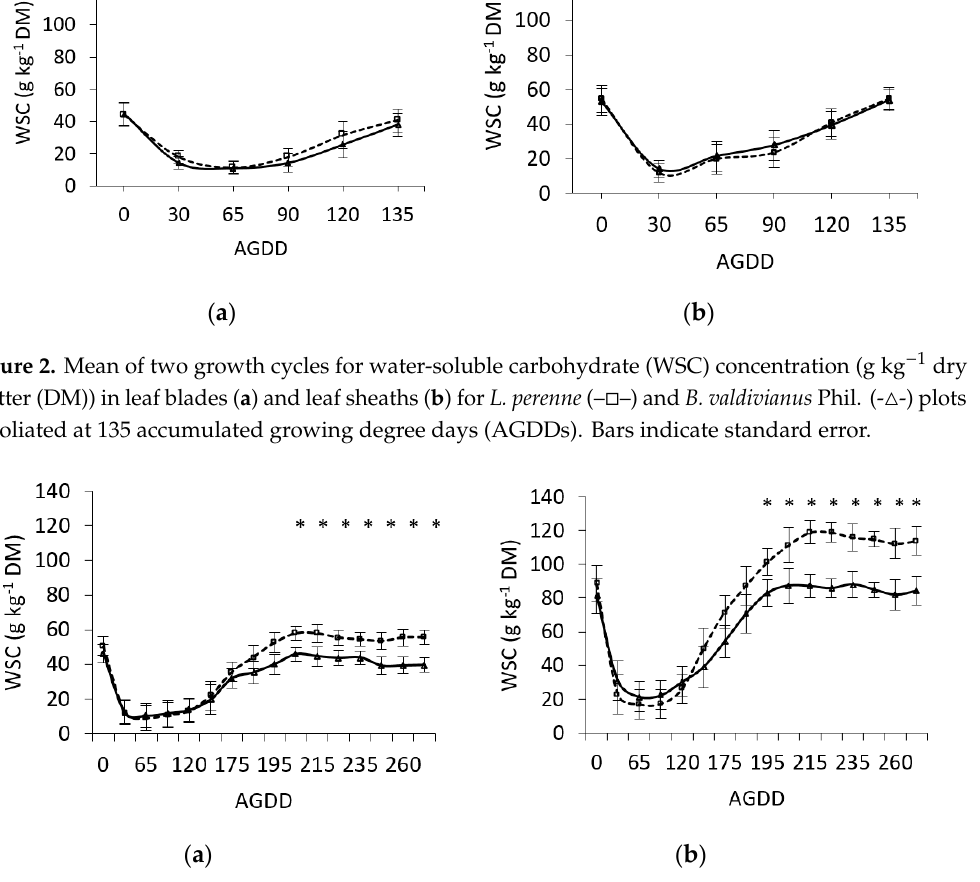
Figure 3. Mean water-soluble carbohydrate (WSC) concentration (g kg -1 DM) post-defoliation in leaf blades ( a ) and leaf sheaths ( b ) for L. perenne (-- □ --) and B. valdivianus Phil. (- △ -) plots defoliated at 270 accumulated growing degree days (AGDDs). * Indicates significant differences ( p < 0.05) between species. Bars indicate standard error.